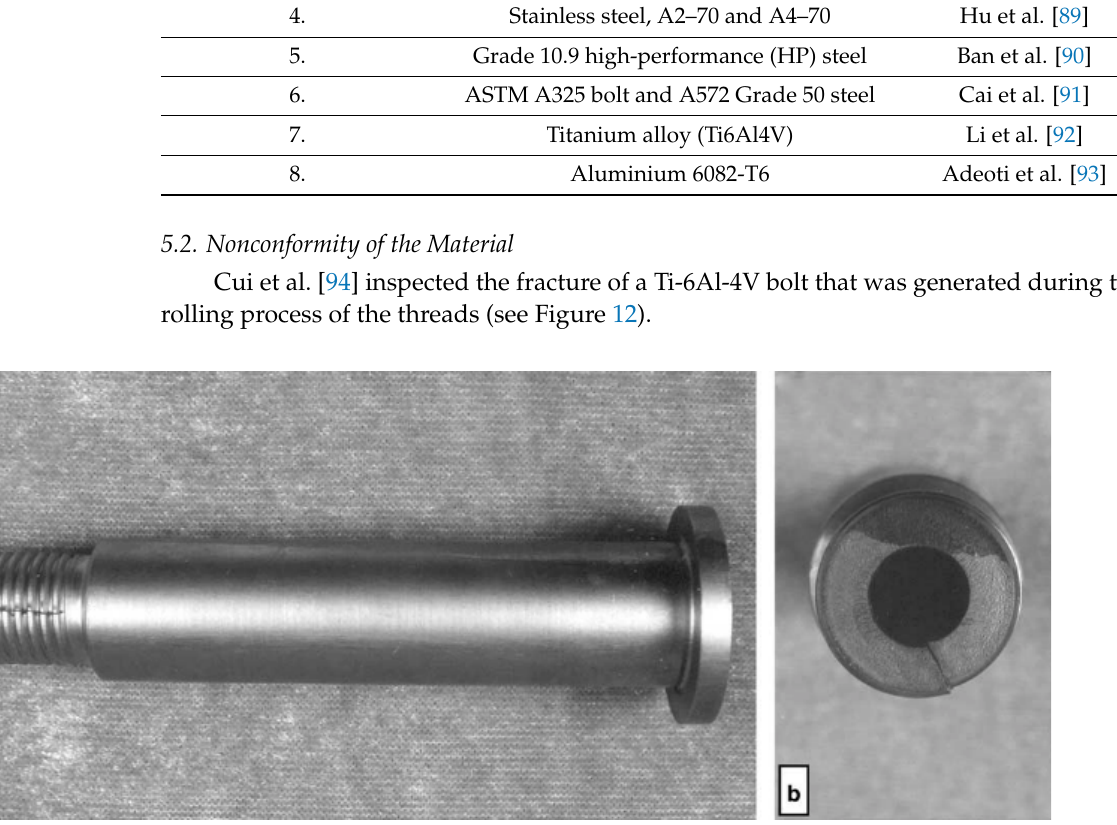
Figure 12. Crack generated on the threaded portion of a special screw upon rolling of the thread. ( a ) Macro crack in the side view. ( b ) Macro crack in cross-section